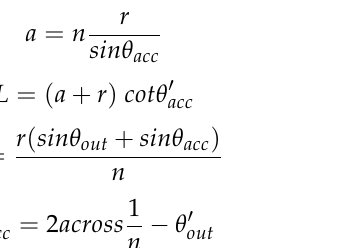
Figure 3. LCPV cross-sectional